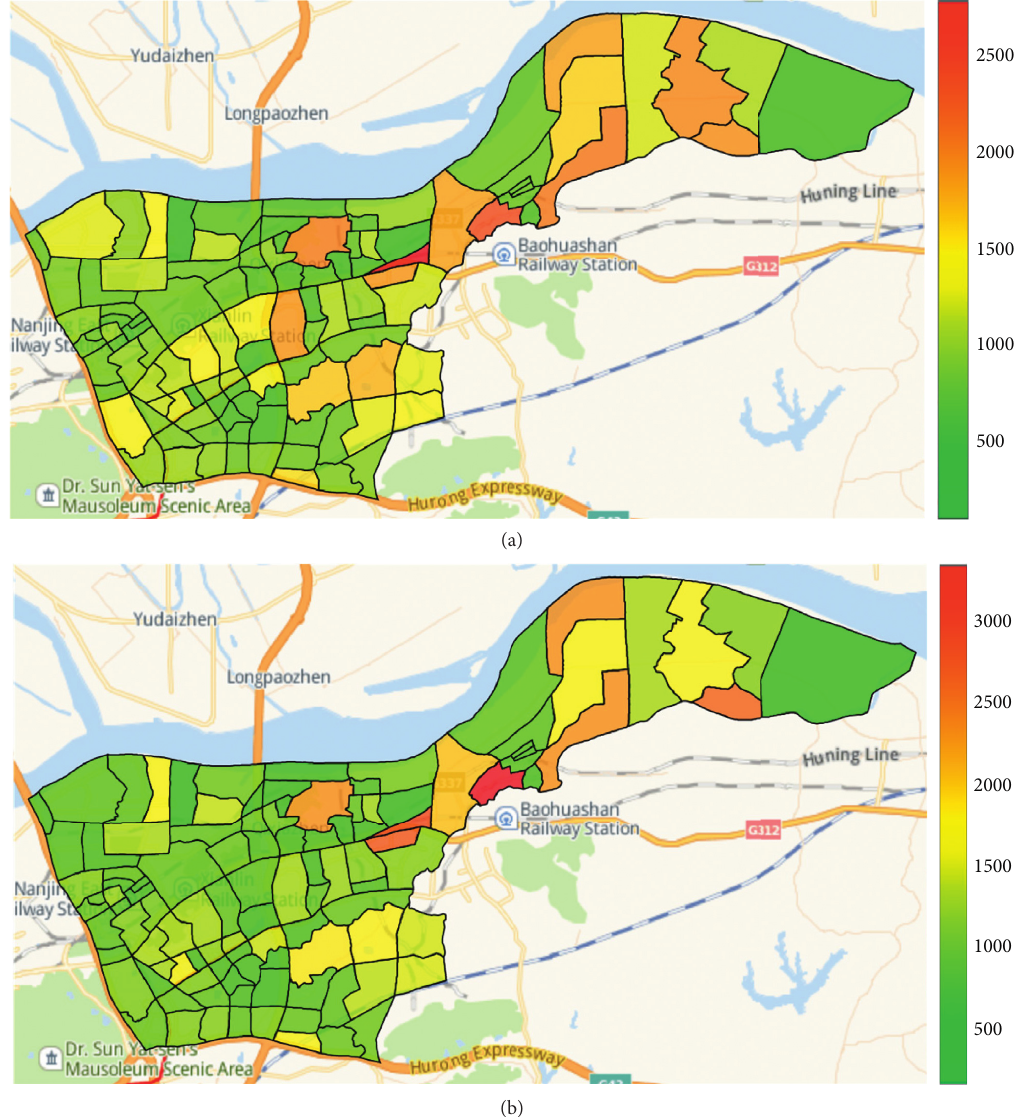
Figure 5: OD matrix of the regions in the Xianlin district. Heat maps of the volumes of goods (a) leaving and (b) entering the